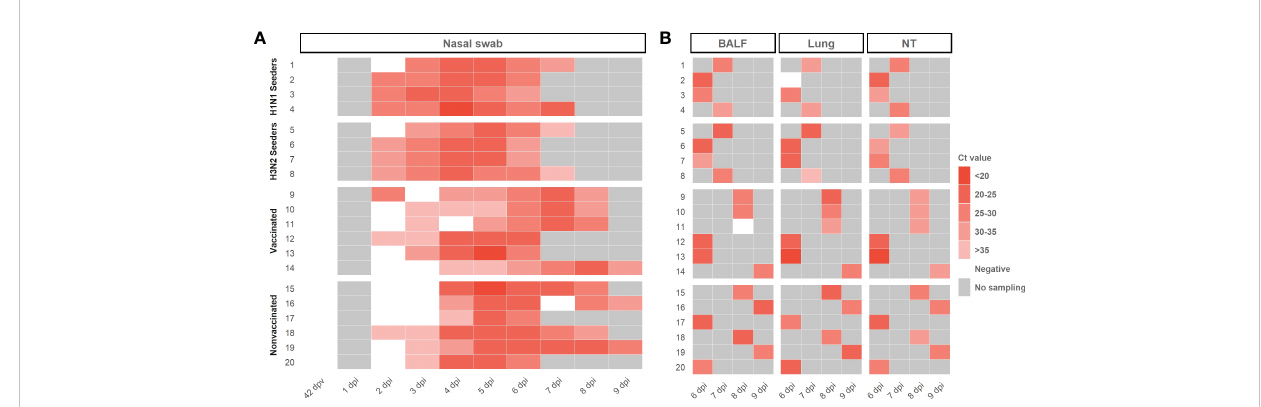
FIGURE 3 Swine IAV genome detection in samples collected from H1N1 and H3N2 seeders, vaccinated and nonvaccinated pigs (A) Daily swine IAV RNA detection in samples collected from nasal swabs. (B) Swine IAV genome detection in BALF, lung, and nasal turbinates collected on the euthanasia day. The Ct values are represented as a heat map where the maximum intense red colors represent higher viral loads and vice versa. RT-qPCR CT values greater than 40 were considered negative, represented in white. No sampling collected was represented as grey. The ID of each animal and the day at which each sample was collected are represented in ordinate and abscissa axes,